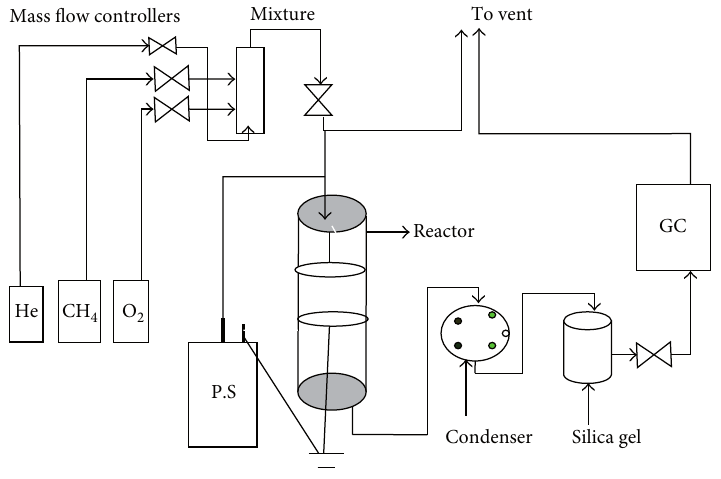
F 1: Platform of Corona Discharge with Feed and Analysis systems.